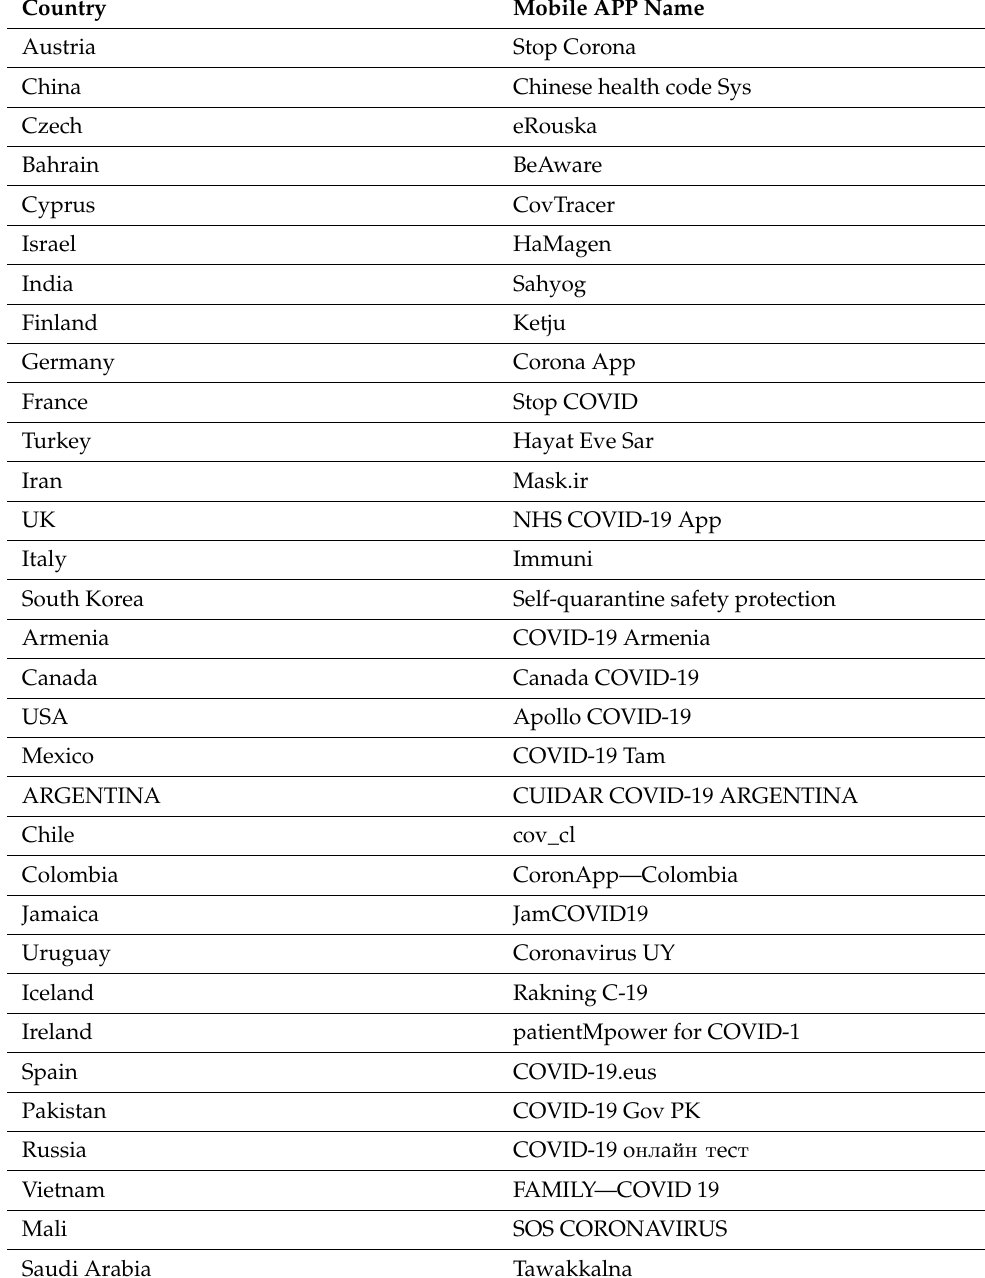
Table 2. Apps by different